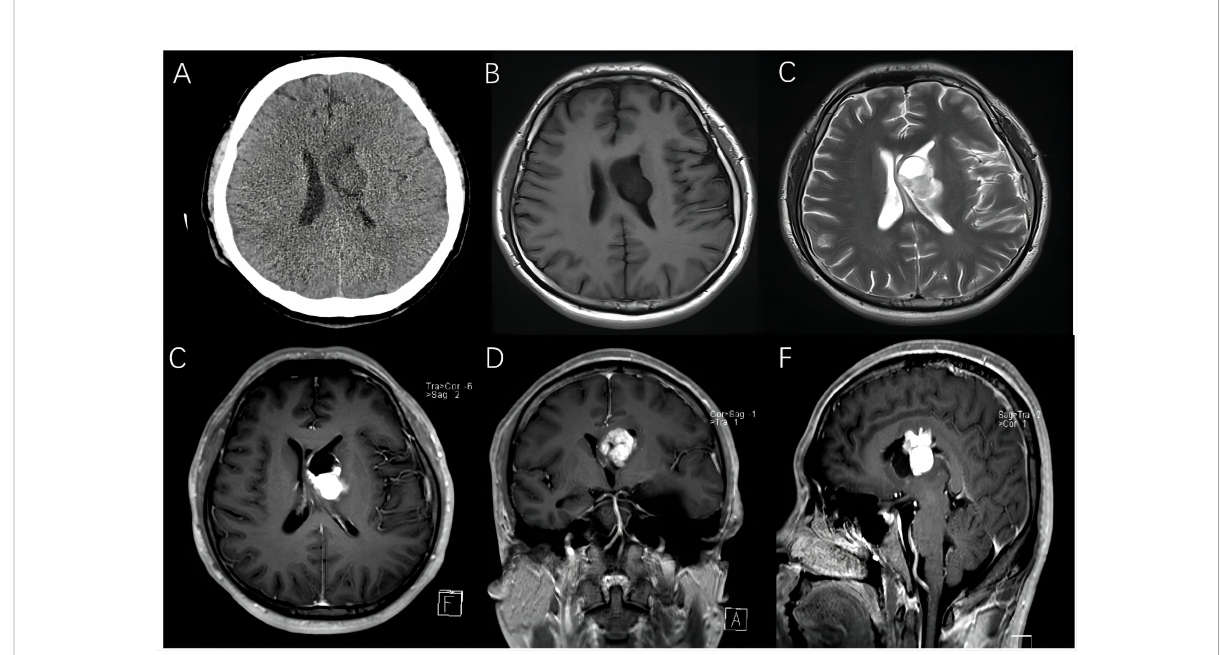
FIGURE 1 Preoperative images of a 27-year-old man with intraventricular hemangioblastoma. (A) CT scans showed a 3.5 cm hypo-isodense mass located in the left lateral ventricle. (B – F) MRI revealed a solid-cystic mass, and the solid part of mass was mildly heterogeneously